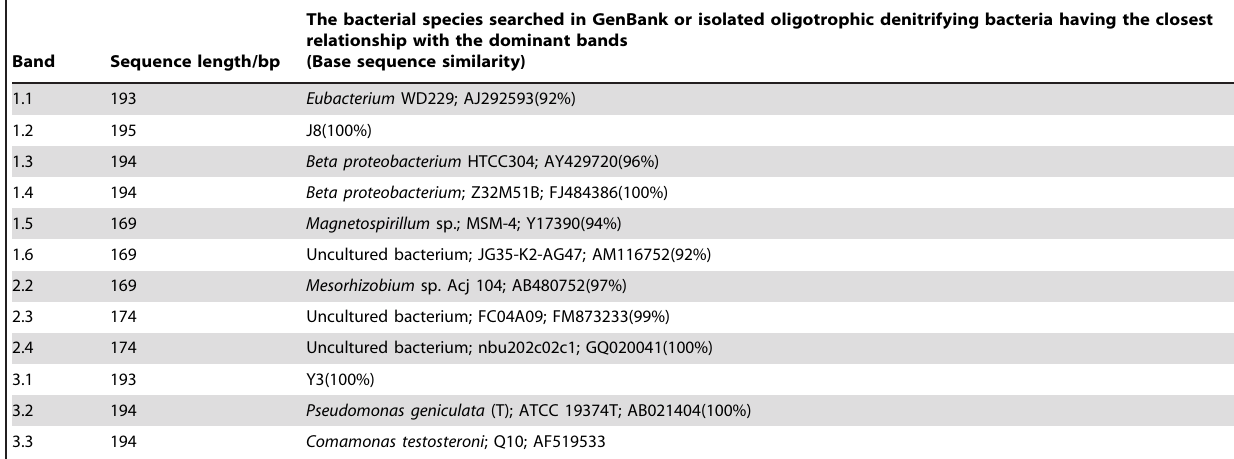
Table 1. Closest relative species or isolated oligotrophic denitrifying bacteria of the selected clones (Determined by an NCBI BLAST